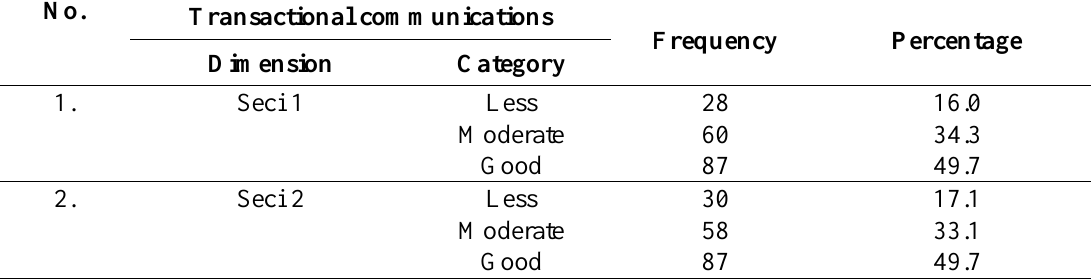
Table 4. Distribution of Respondent based on Transactional Communication Factor